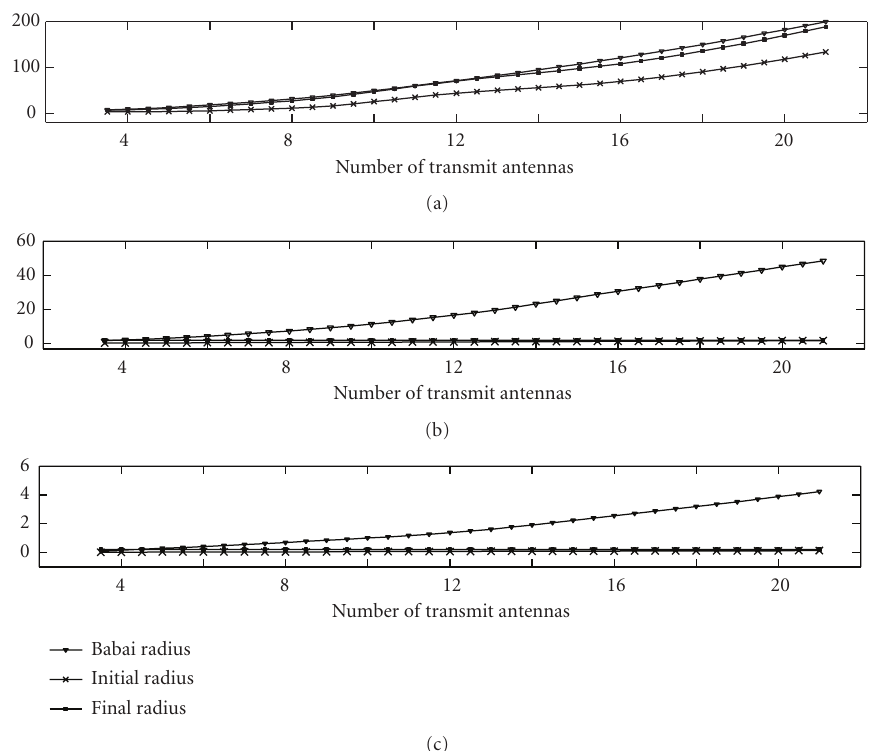
Figure 5: C f , the proper C 0 , and C ba of SE-SD versus the number of antennas for 64QAM. (a) σ 2 = 0 . 65, (b) σ 2 = 0 . 203,and(c) σ 2 = 0 .